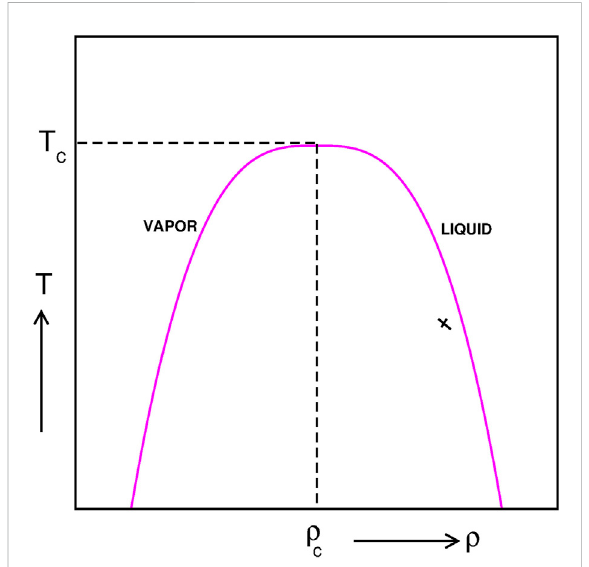
Schematic phase diagram of a single-component fl uid in the temperature-densityplane. T c and ρ c markthecriticaltemperature and critical density, respectively. Above T c the fl uid is in a homogeneous state and below T c it is in a two-phase coexistence state. Upon a temperature quench from a high temperature inside the binodal at ρ c percolating domain morphology is observed. Cross refers to an off-critical quench for which droplets form and they grow in size by coalescence among each other.